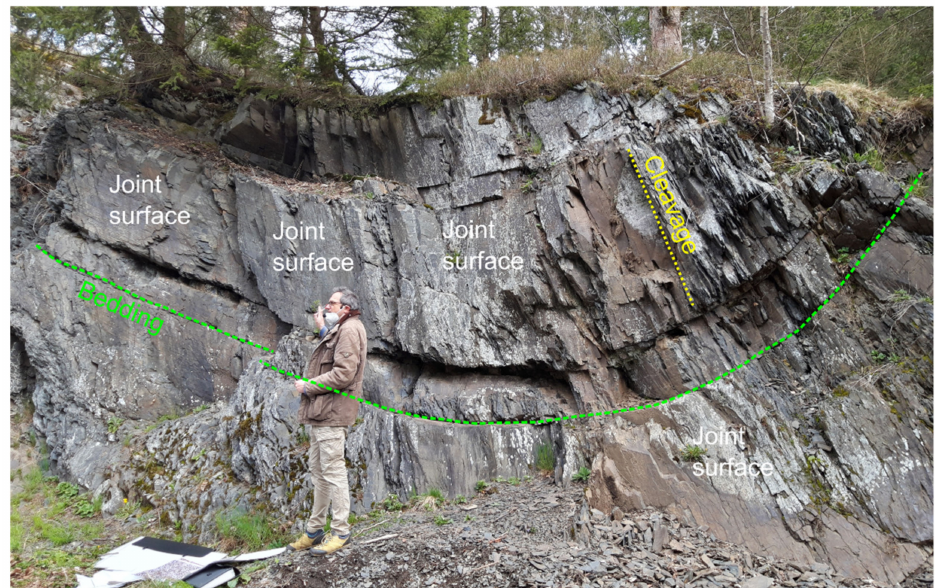
Figure 2. Photograph of a syncline in Upper Palaeozoic slates at Schulenberg im Oberharz, Harz Mountains, Germany. Most of the exposure surface is defined by a set of steeply dipping joints that strike at a high angle to the